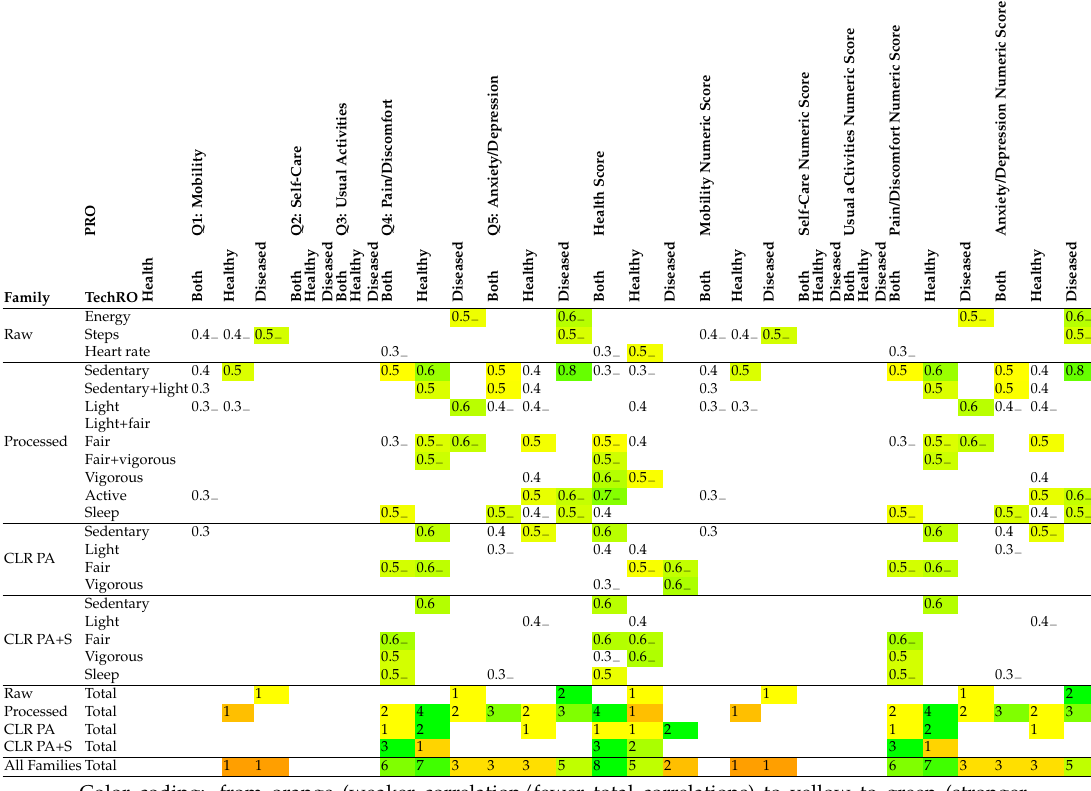
Color coding: from orange (weaker correlation/fewer total correlations) to yellow to green (stronger correlation/more total correlations). Only significant correlations are shown. Only coefficients of 0.5 or above are